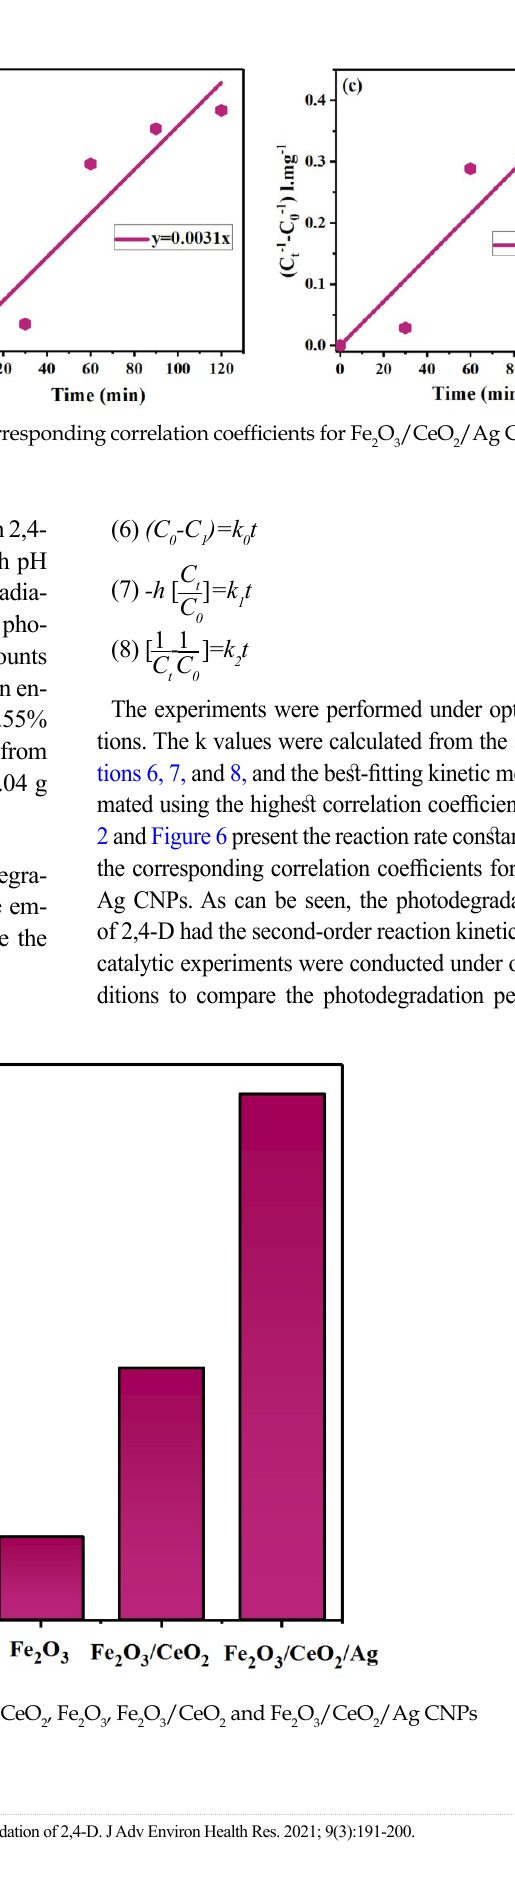
Figure 7. Comparison of 2,4-D photodegradation with CeO